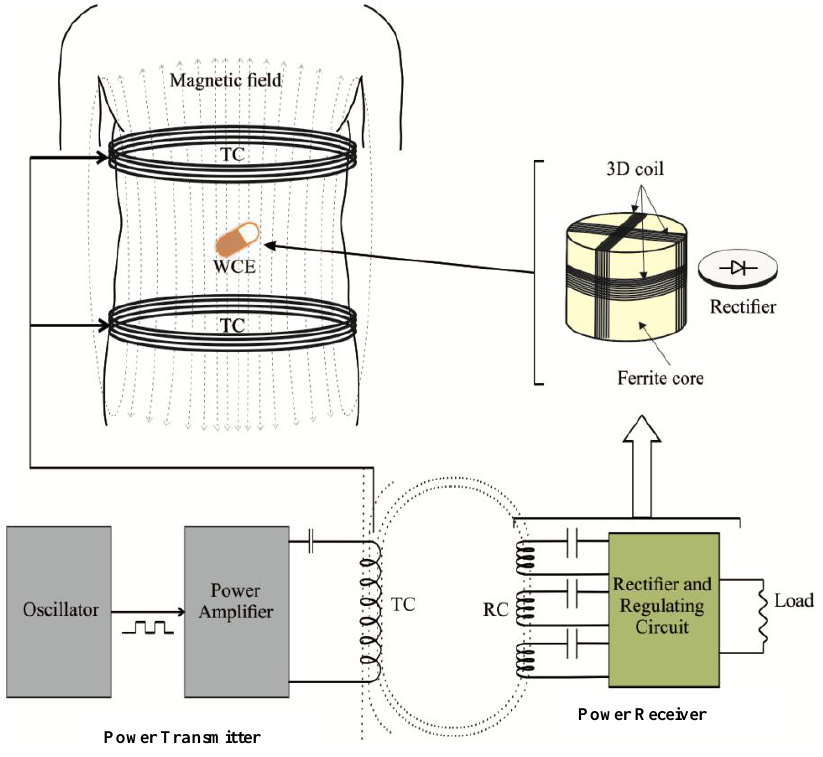
Figure 2. Illustration of WPT system in WCE